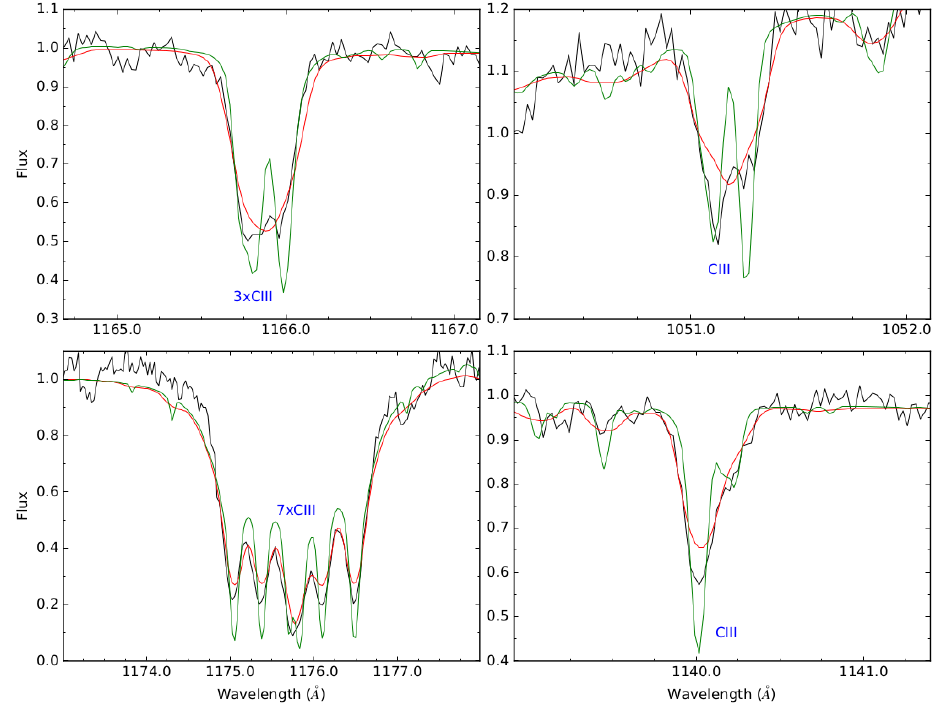
Figure 2. Fit of carbon lines in the FUSE spectrum of [CW83]0904-02 (red) and line profiles without rotation (green).